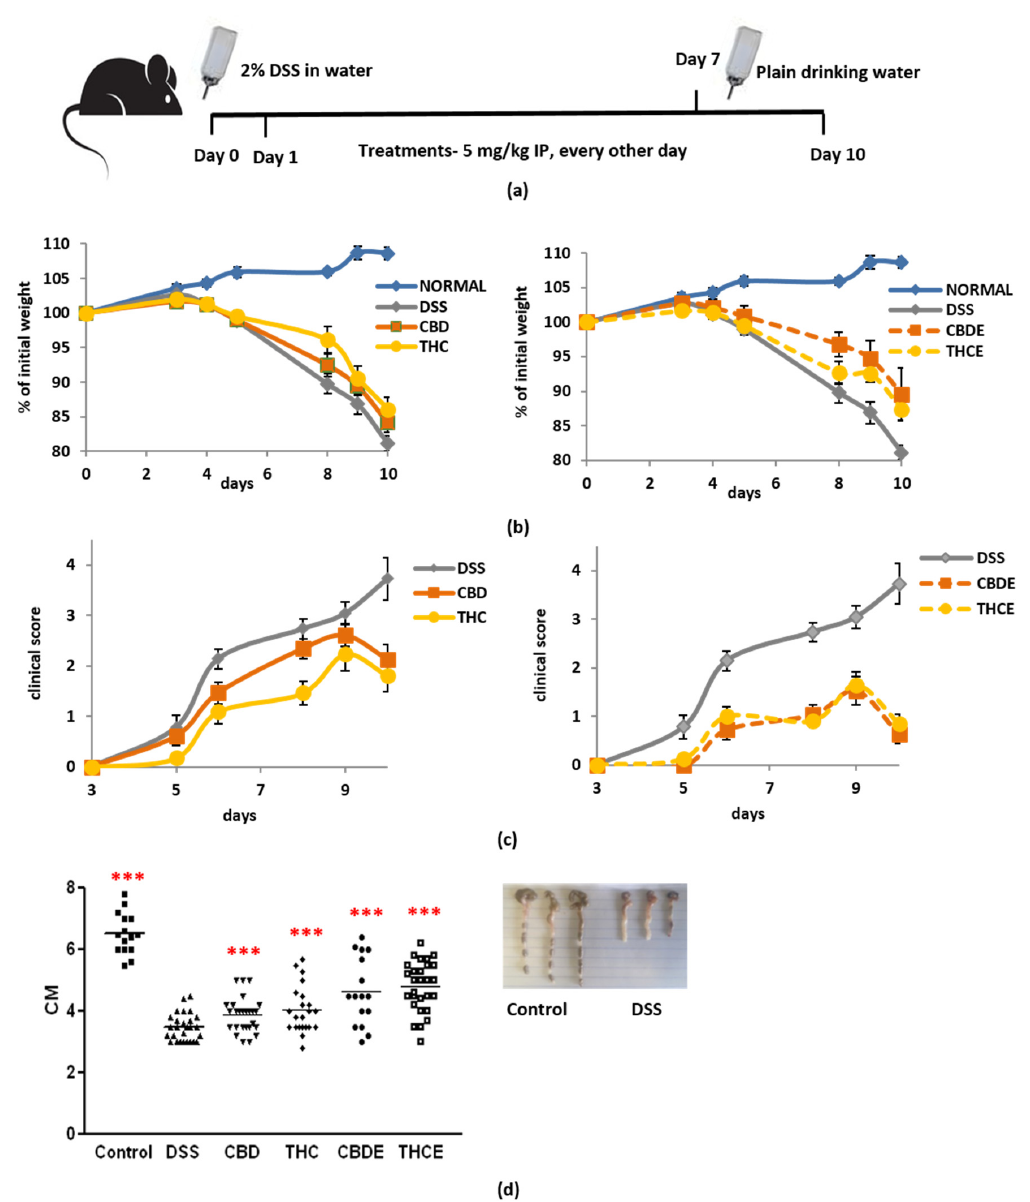
Figure 4. Cannabis/cannabinoids administration for treatment of murine colitis in DSS model mice: ( a ) Acute colitis was induced by adding DSS to the mice drinking water at 2% (wt/vol) ad libitum for 7 days, and then replaced with plain water. 5 mg/kg cannabis/cannabinoids were administered IP every other day, starting from Day 1; ( b ) the effect of pure cannabinoids (left) and cannabis ex- tracts (right) on weight loss. Differences between DSS group and THCE- as well as CBDE-treated groups are significant. The difference between the CBD- and CBDE-treated groups is significant p < 0.05; ( c ) the effect of pure cannabinoids (left) and cannabis extracts (right) on clinical score. Differ- ences between the DSS group and all cannabinoid-treated groups are significant p < 0.005. Differ- ences between cannabis extracts and pure cannabinoids are significant p < 0.008. The difference be- tween the CBD- and THC-treated groups is significant p < 0.05; ( d ) the effect of pure cannabinoids and cannabis extracts on colon length, at the end of the experiment (Day 10). P -value as compare with the DSS control group ***, <0.001. The differences between THCE and THC and between CBDE and CBD are significant. Data are summarized from 5 independent experiments, 5–7 mice/group in each experiment. DSS—dextran sodium sulfate; THC—D9 tetrahydrocannabinol; CBD—canna- bidiol; THCE—high THC cannabis extract; CBDE—high CBD cannabis extract.